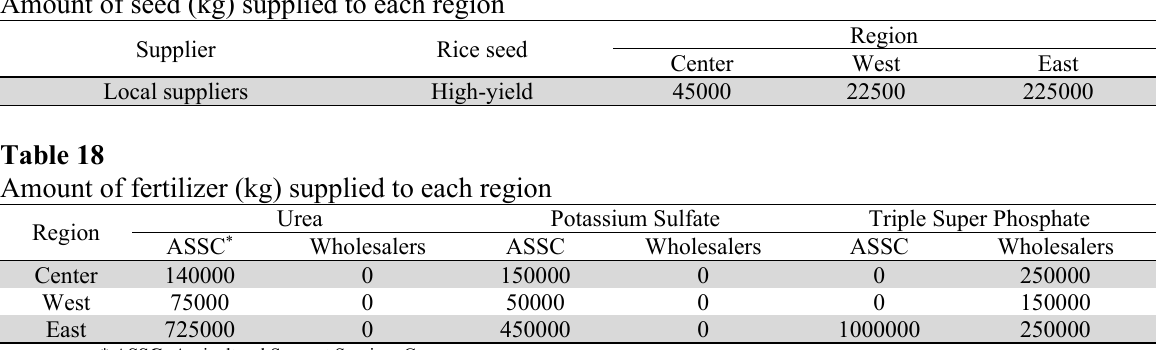
* ASSC: Agricultural Support Services